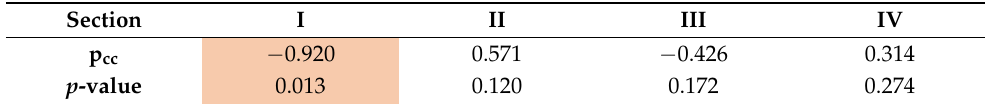
Table 6. Circular correlations (p cc ) between the hue angle (h ◦ ) of the “intermediary” and main colors in Sections I, II, III, and IV.